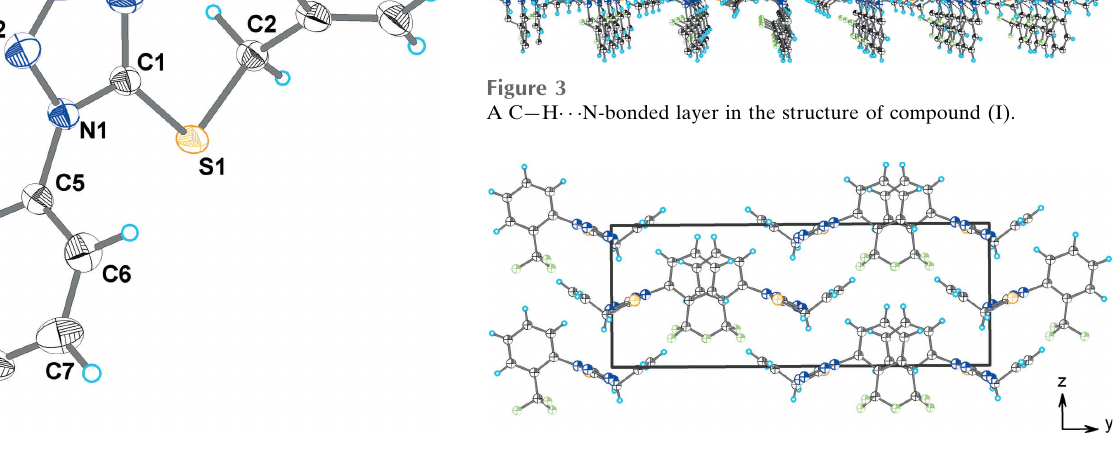
Figure 4 A view along the a axis of the crystal packing of the title